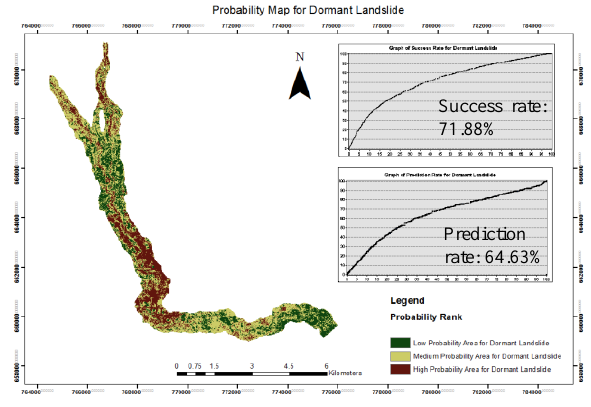
Figure 18. Probability map of dormant landslide Figure 19 shows the probability map for the relict landslides.